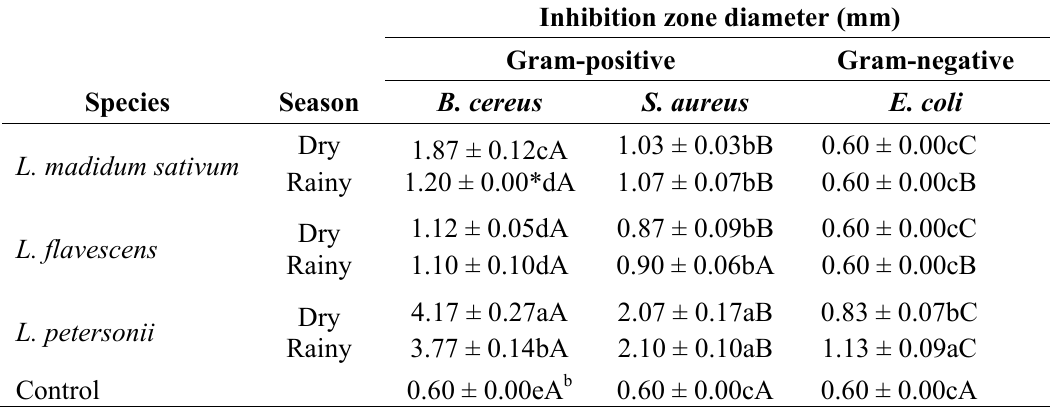
Table 4. Antibacterial activities of the volatile oils from Leptospermum